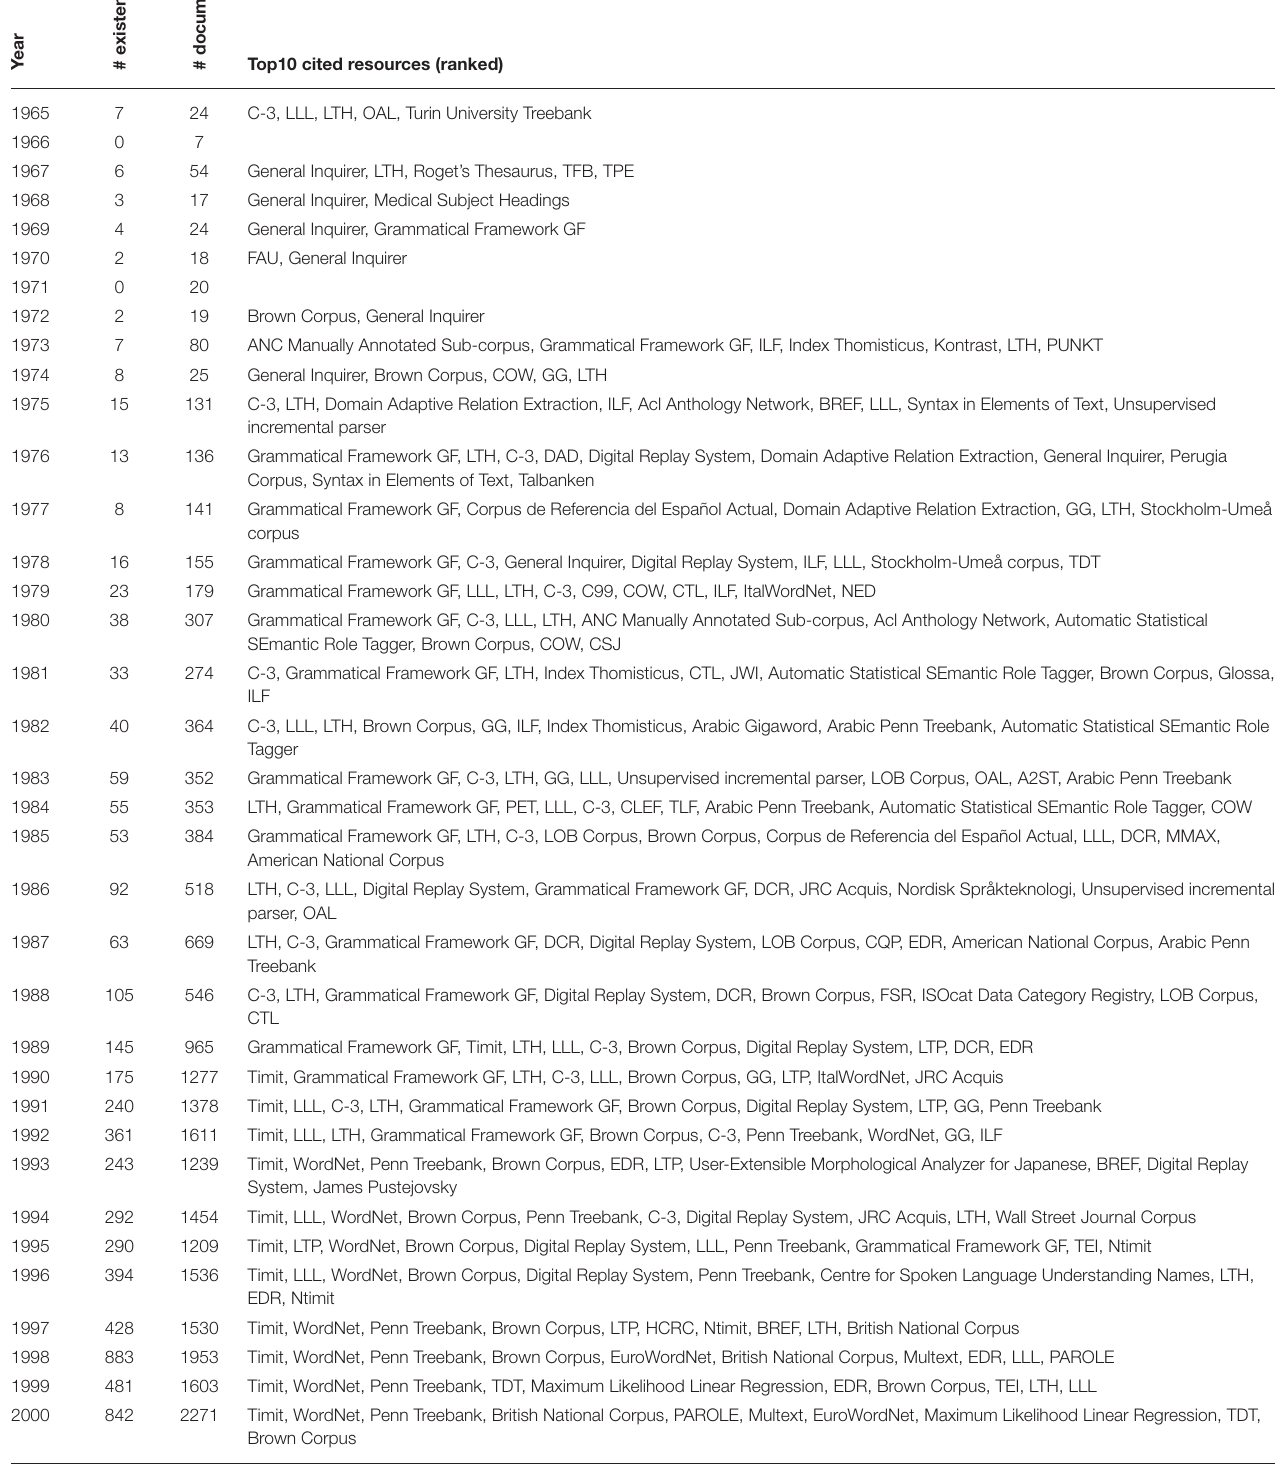
TABLE A2 | Ranked top 10 mentioned LRE map language resources per year